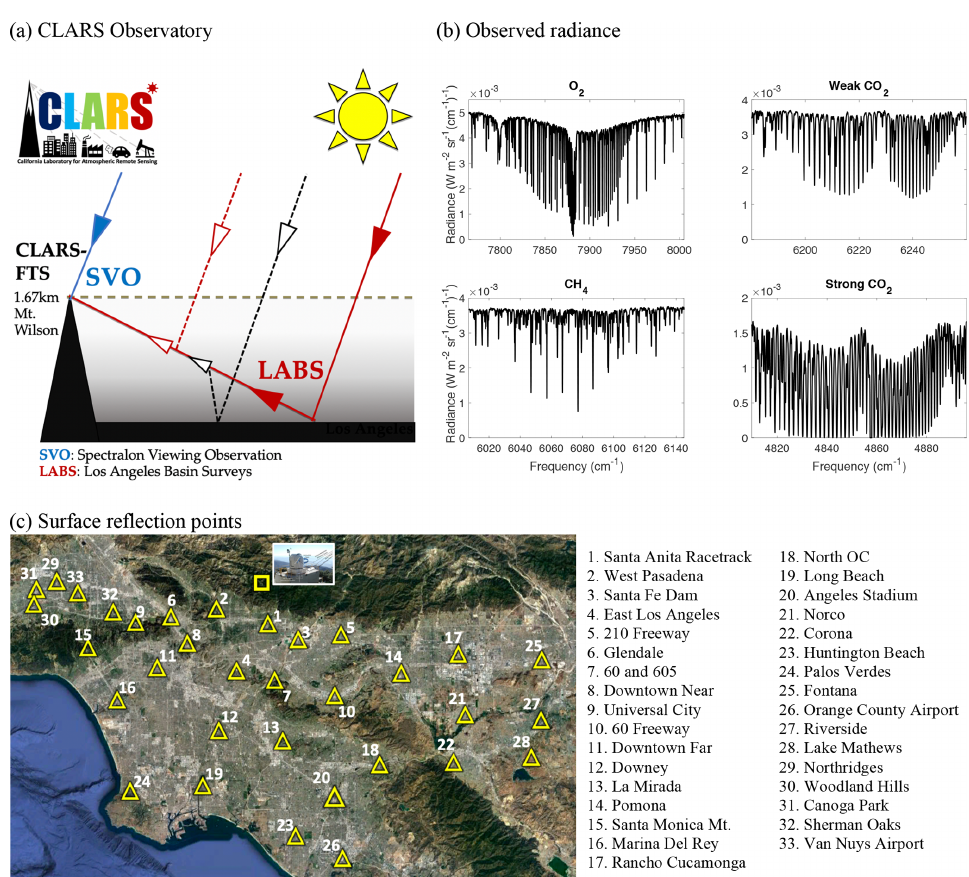
Figure 1. (a) Schematic figure of the CLARS observatory. The lines depict incident and reflected sunlight from an example surface reflection target. The LABS and Spectralon viewing observation (SVO) modes are illustrated. For the LABS mode, examples of contributions from single scattering (dotted red) and multiple scattering (dotted black) are also illustrated. (b) Examples of observed high-resolution (0.06cm − 1 ) spectra for the O 2 1 (cid:49) absorption band centered at 1.27µm (7885cm − 1 ), the weak CO 2 absorption band at 6220cm − 1 , the CH 4 absorption band at 6076cm − 1 , and the strong CO 2 absorption band at 4852cm − 1 . These measurements were made on 28 September 2013 over the Santa Anita Racetrack surface reflection point at local noon. (c) The 33 surface reflection points across the Los Angeles Basin. The background image is adopted from © Google